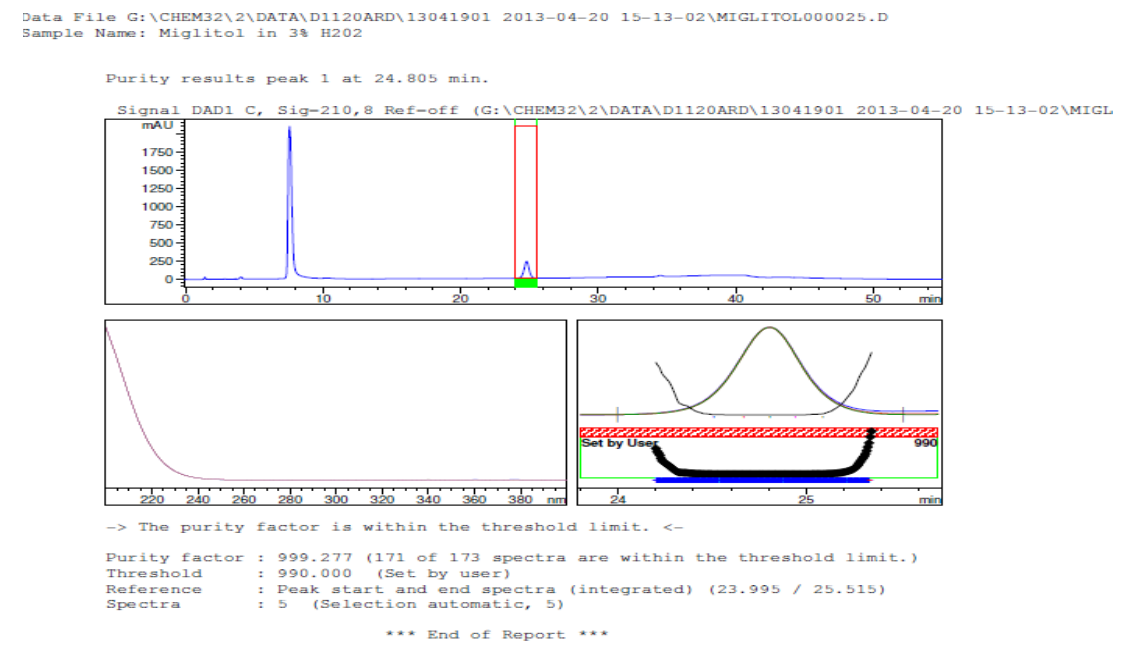
Figure 9. Peak purity in base degradation by diode array detector.